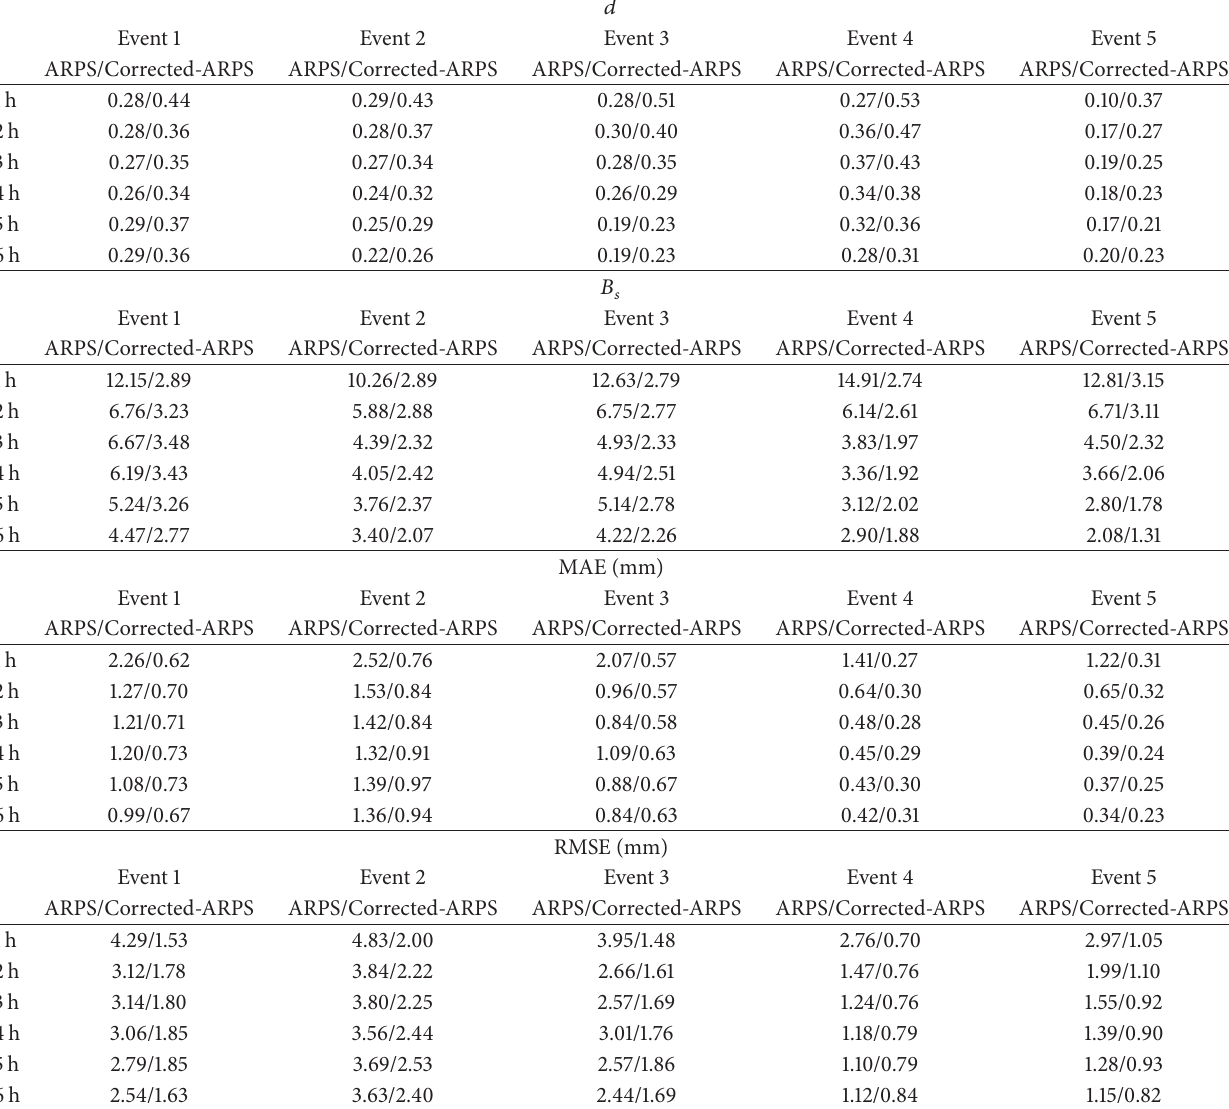
Table 1: Mean forecast performances based on standard measurements of the original and the corrected ARPS for lead times from 1h to 6h for five heavy rain